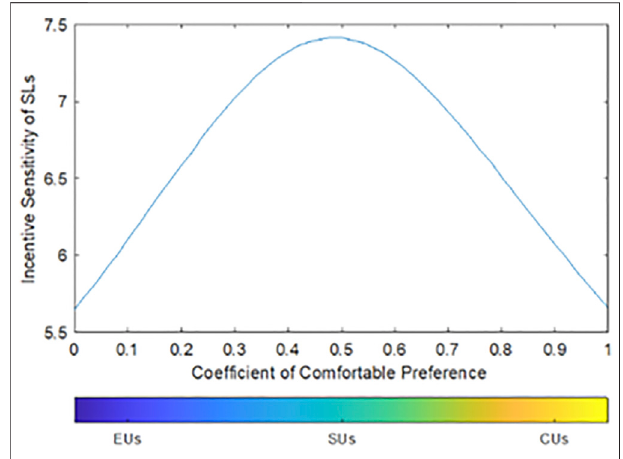
FIGURE 5 | Relationship between SLs ’ incentive sensitivity and their preference structures under asymmetric